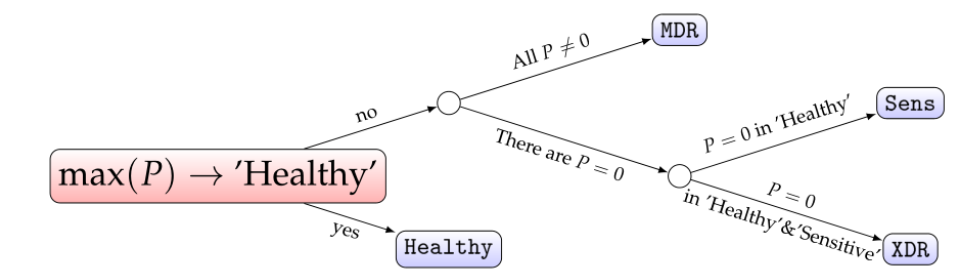
Figure 4. The decision tree summarising the workflow of determining the drug resistance status based on the postprocessing of raw values of probabilities assigned by the C AT B OOST